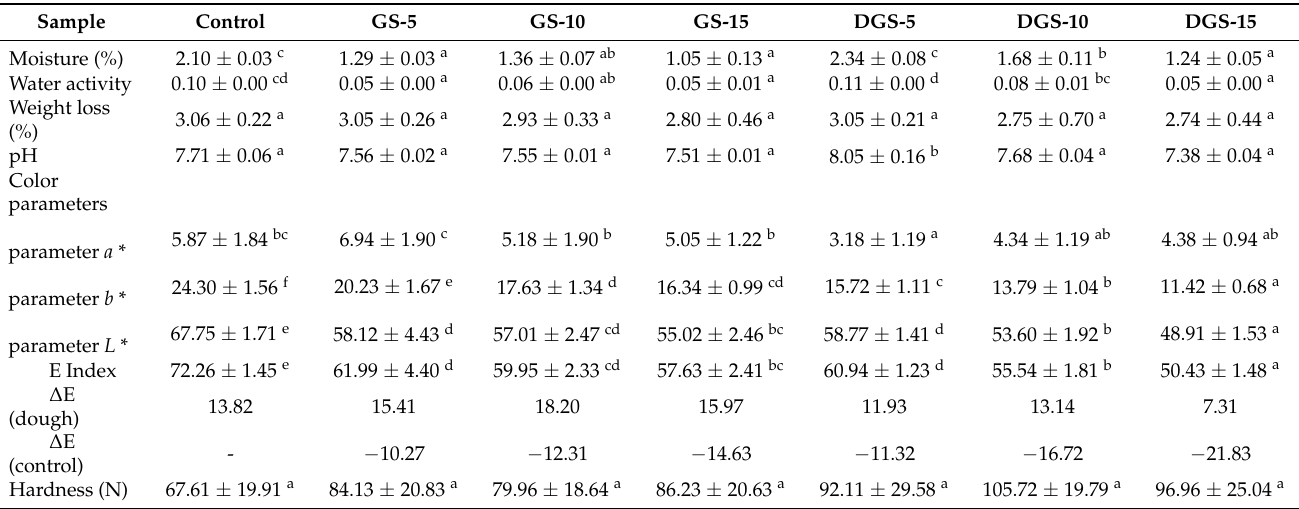
Table 4. Physicochemical characterization of biscuits with or without chia